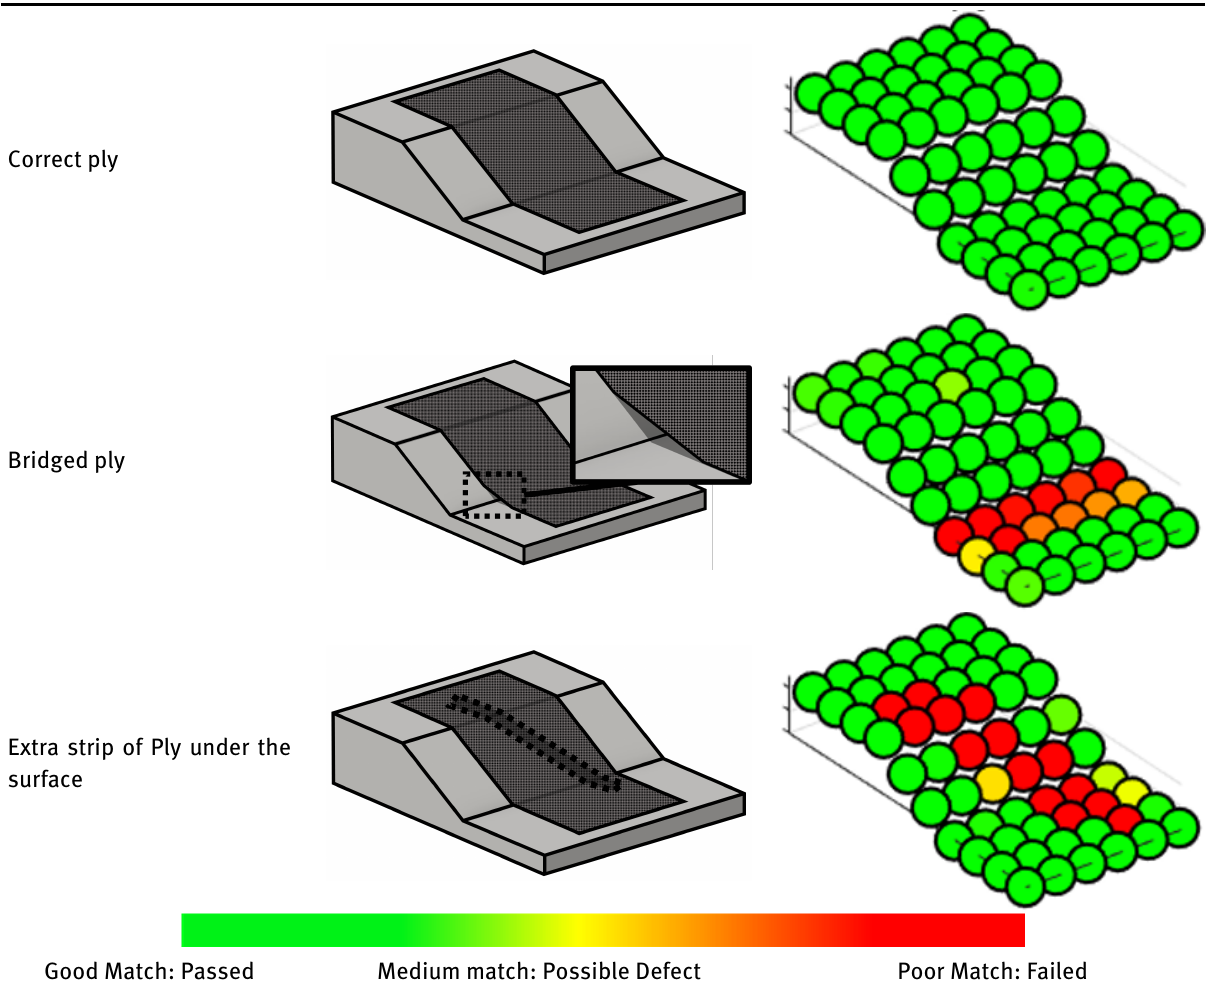
Table 2: Results of TacTip scans on the Complex curved layup